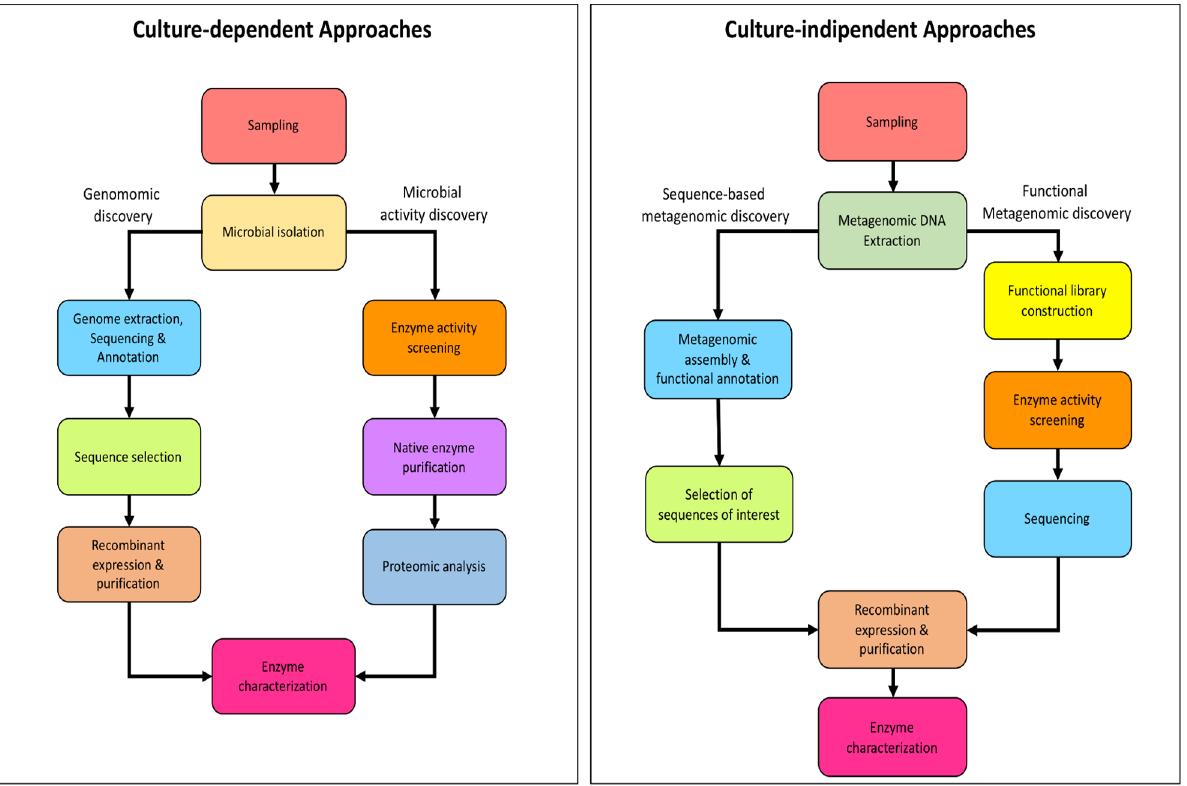
Figure 7. Schematic flowcharts of enzyme discovery approaches.